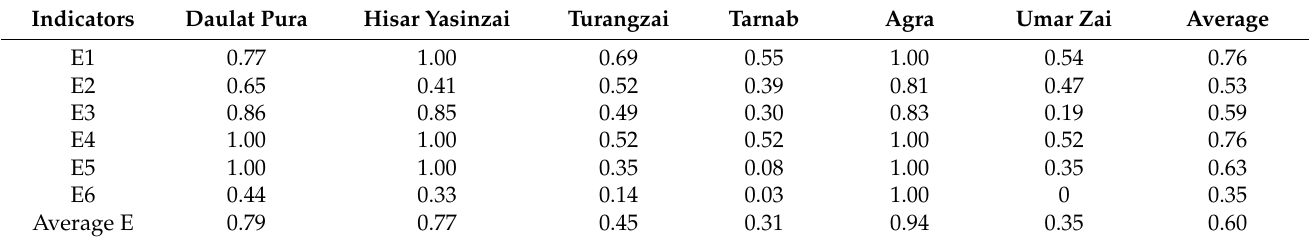
Table 4. Household exposure to floods.